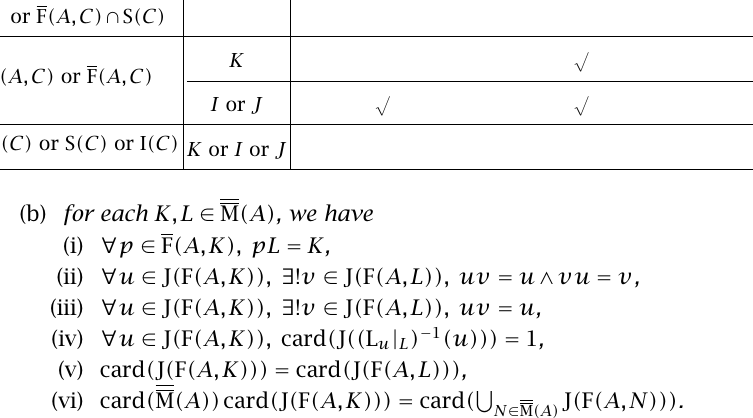
F (A,C) ∩ B (C) F (A,C) or F (A,C) B (C) or S (C) or I (C) G or F (A,C) ∩ S (C) D or F (A,C) ∩ B (C) C or F (A,C) ∩ S